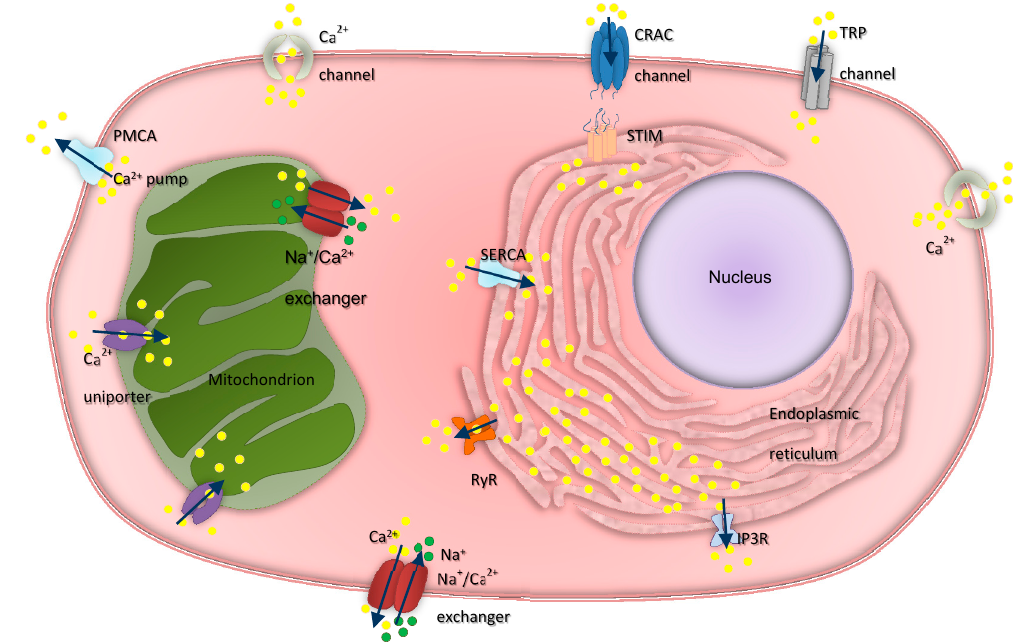
Figure 1. Calcium homeostasis. Ca 2 + channels, pumps, and exchangers act in synergy to maintain normal calcium concentrations. PMCA = plasma membrane Ca 2 + -ATPase, CRAC = calcium release-activated channel, TRP = transient receptor potential channel, IP3R = inositol trisphosphate receptor, RyR = ryanodine receptor, SERCA = sarco- / endoplasmic reticulum Ca 2 + -ATPase, PMCA = plasma membrane Ca 2 + -ATPase.